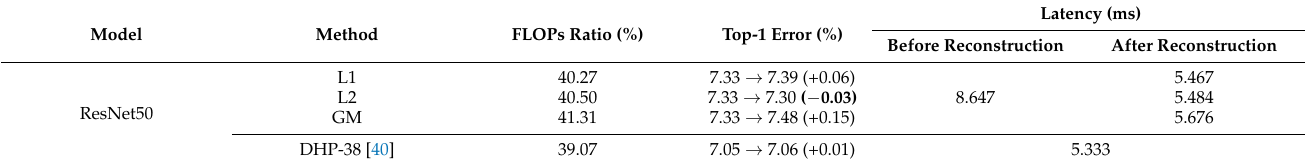
Table 6. Comparison of pruned ResNet50 with previously introduced pruned ResNet50 in DHP [40]